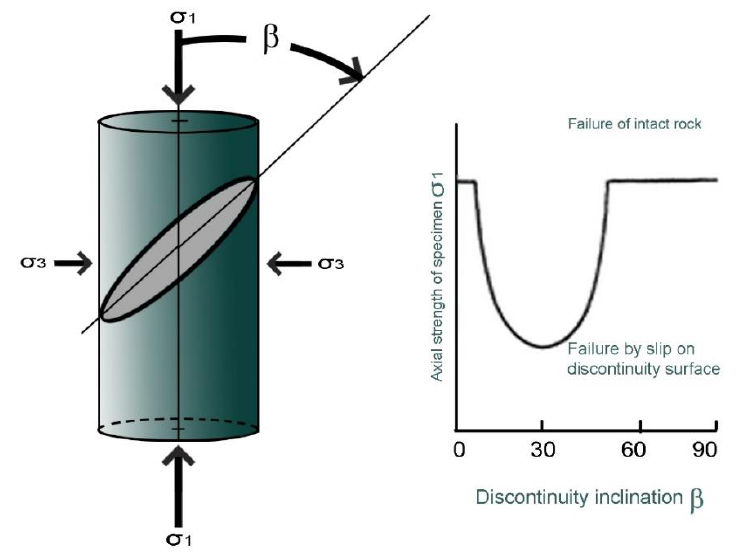
Figure 6. Single plane-of-weakness theory (reproduced from Saroglou and Tsiambaos [180]).